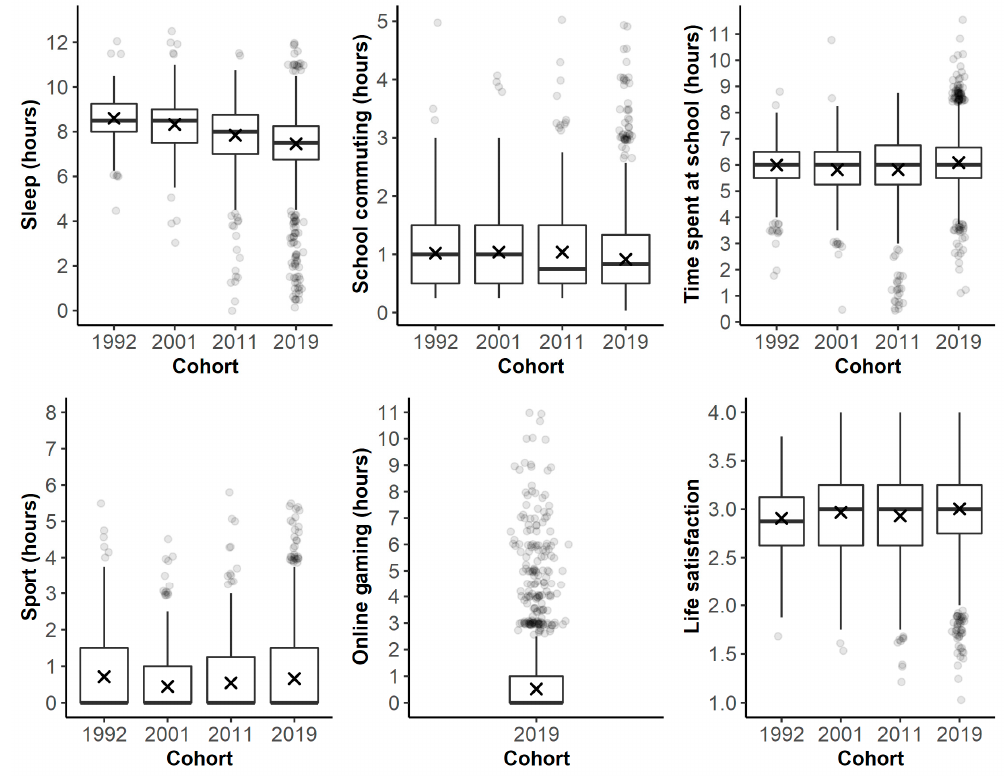
Figure 1. Duration of different daily activities and life satisfaction by cohort. Note. Online gaming was measured only in the last cohort (2019). The symbol “×” marks 5% trimmed means.